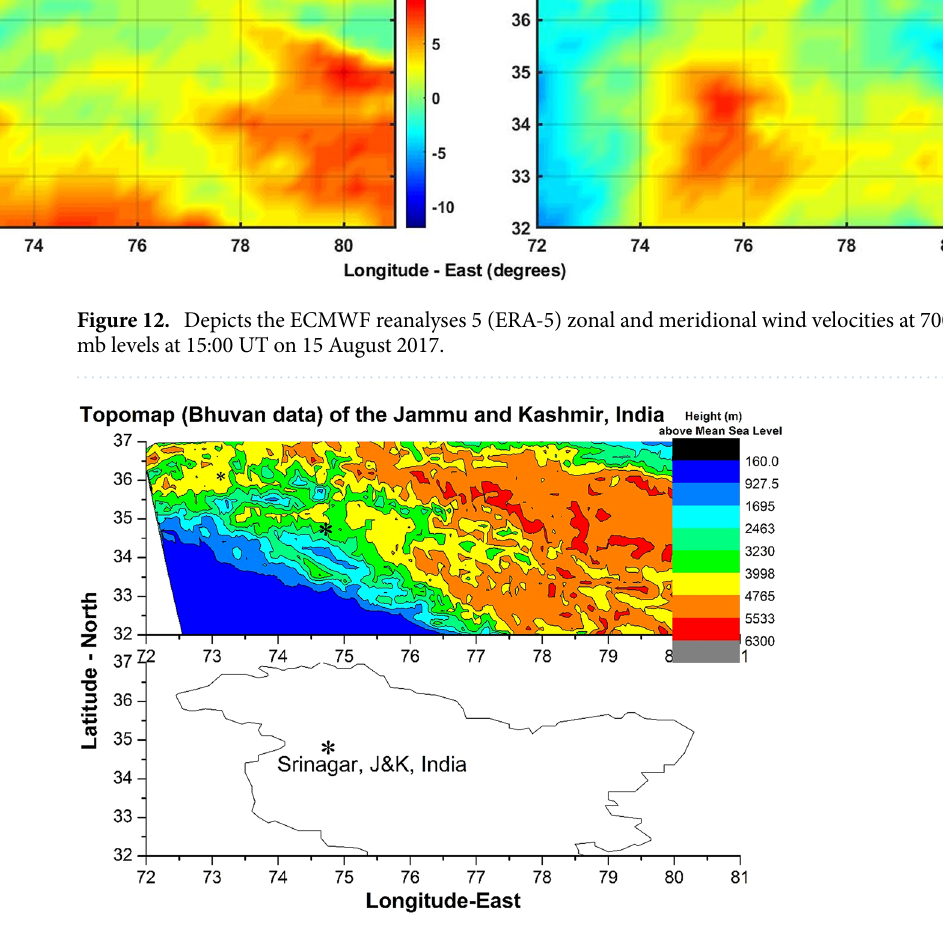
Figure 13. Shows the topographic (ISRO-Bhuvan data) structure of the erstwhile state of Jammu and Kashmir (J&K), India corresponding to the Fig. 10. The imager station, Srinagar, marked as asterisk symbol, is located in the present J&K Union Territory of India. The outline of the map is obtained from digital values of latitudes and longitudes associated with geographic outline of India as available in the official Indian government portal website of https:// india maps. gov. in/